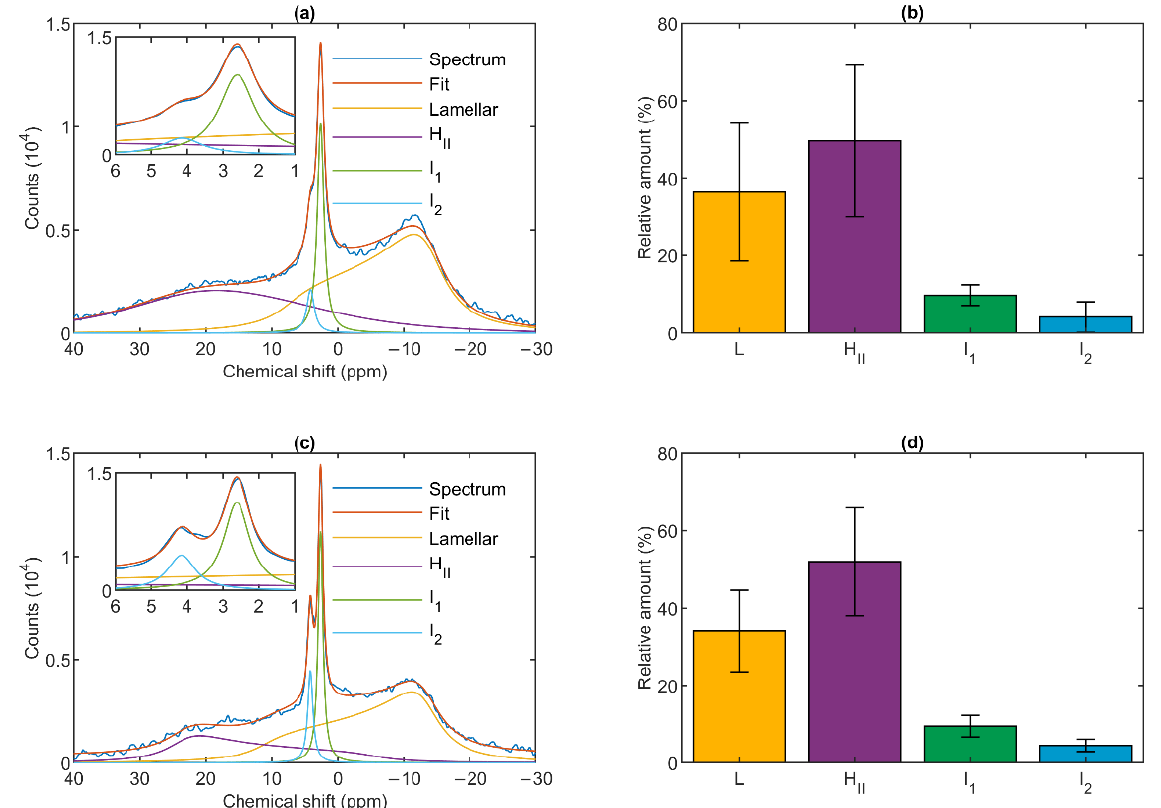
Figure 1. 31 P-NMR spectra ( a , c ) and relative intensities ( b , d ) of isolated spinach granum ( a , b ) and stroma ( c , d ) thylakoid membranes at 5 °C. Average of ( a ) five spectra from three batches and ( c ) six spectra from five batches. Integrated areas of the component spectra ( b , d ) associated with the different lipid phases, relative to the overall integrated area; mean values ± SD.